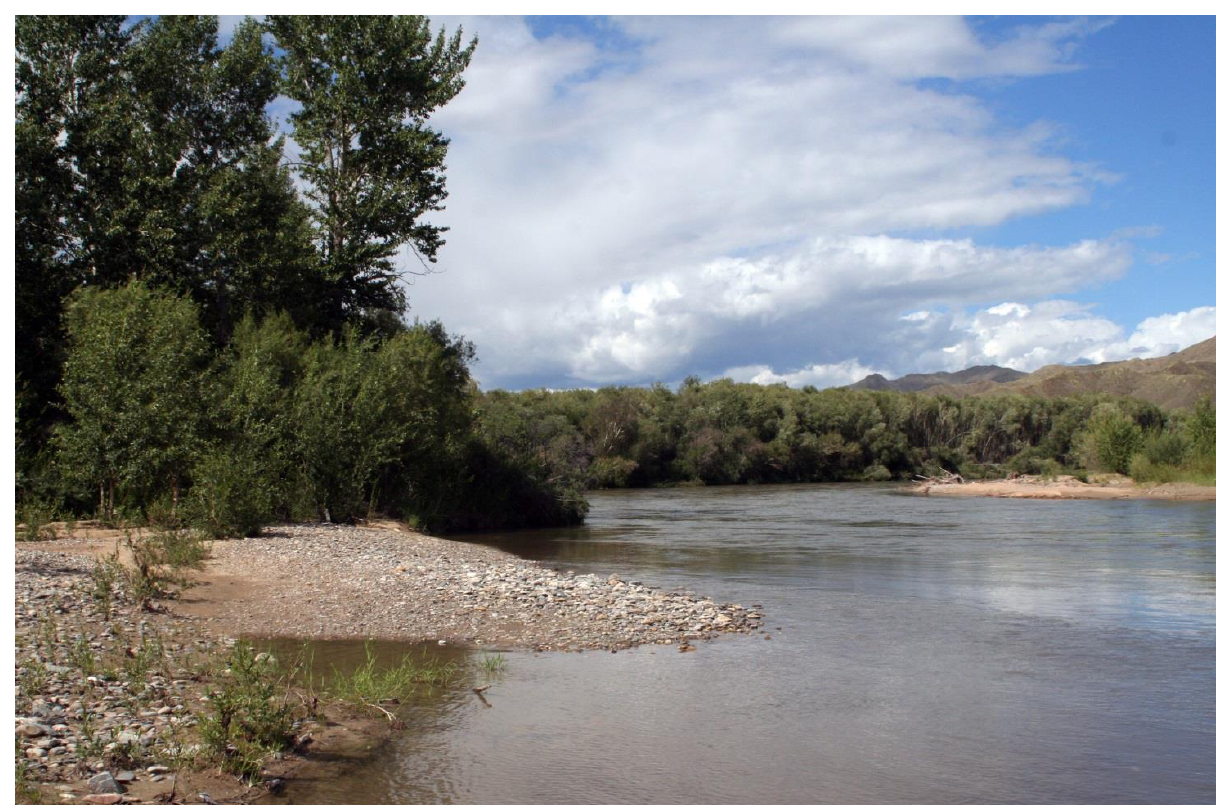
Fig. 6. Tes-Khem River. Tes-Khem Kozhuun, 4 July